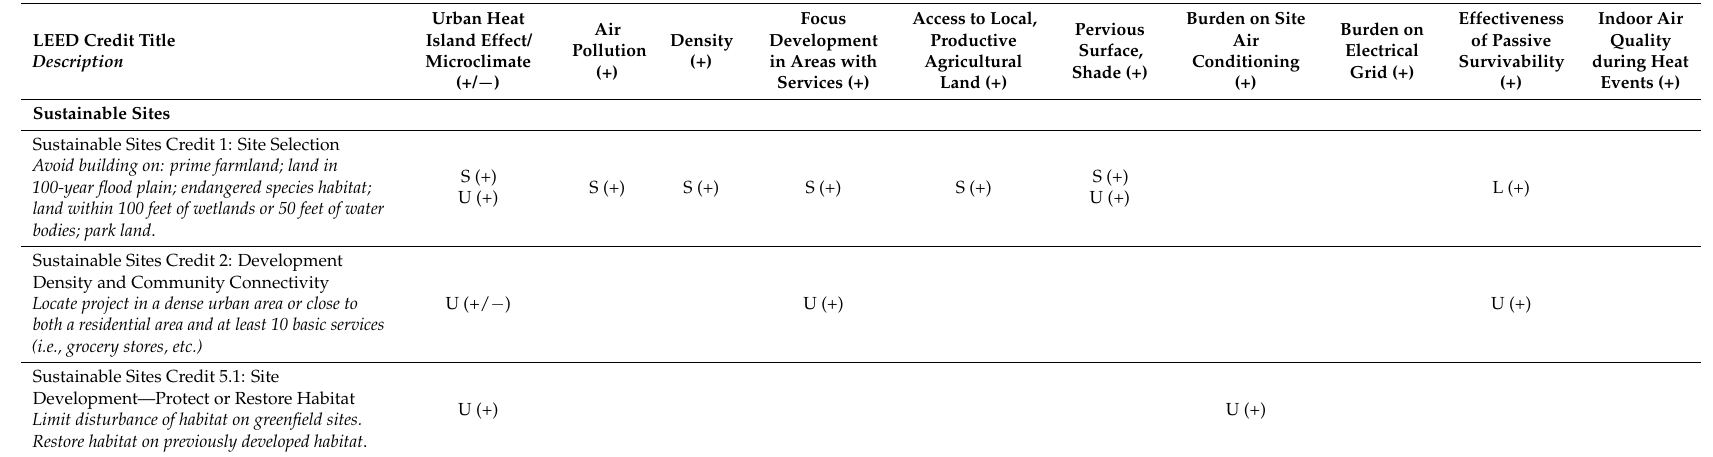
Table 3. Potential Co-Benefits (+) and Co-Harms ( − ) of LEED Credit Requirements on Heat-Related Built Environment Outcomes, Categorized by Environmental Exposure. LEED Credit Title